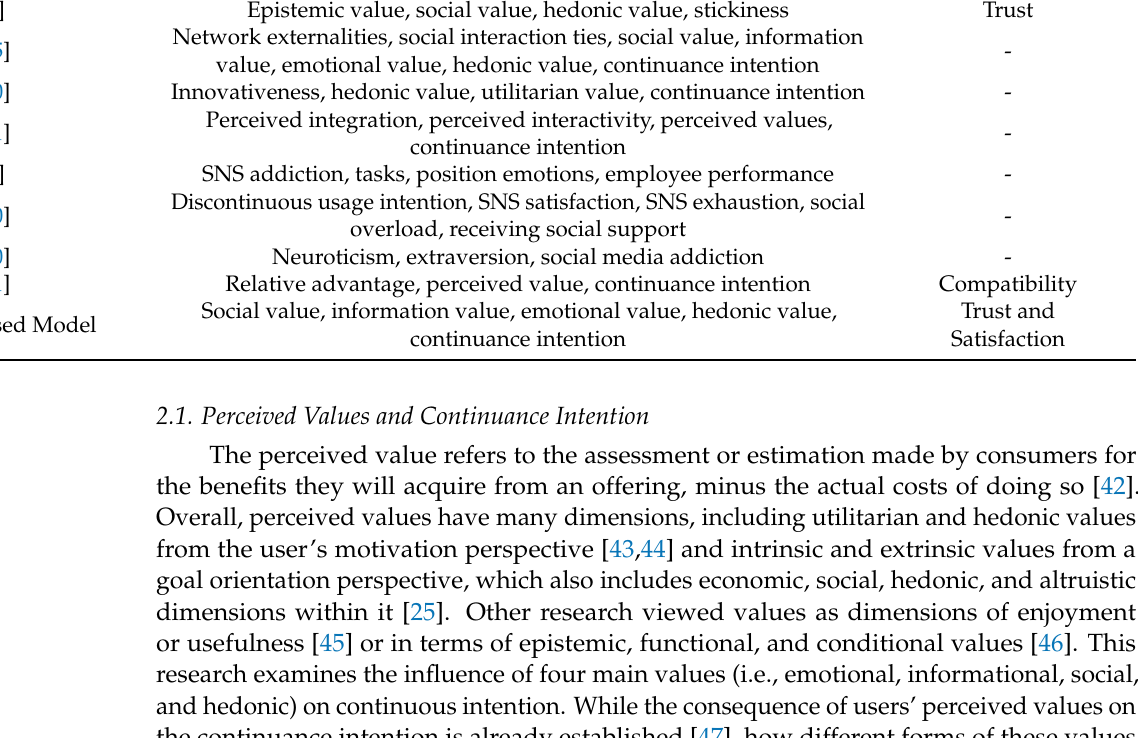
Table 1. Some recent research based on continuance behaviour, perceived values, and addiction. Literature Variables Moderators